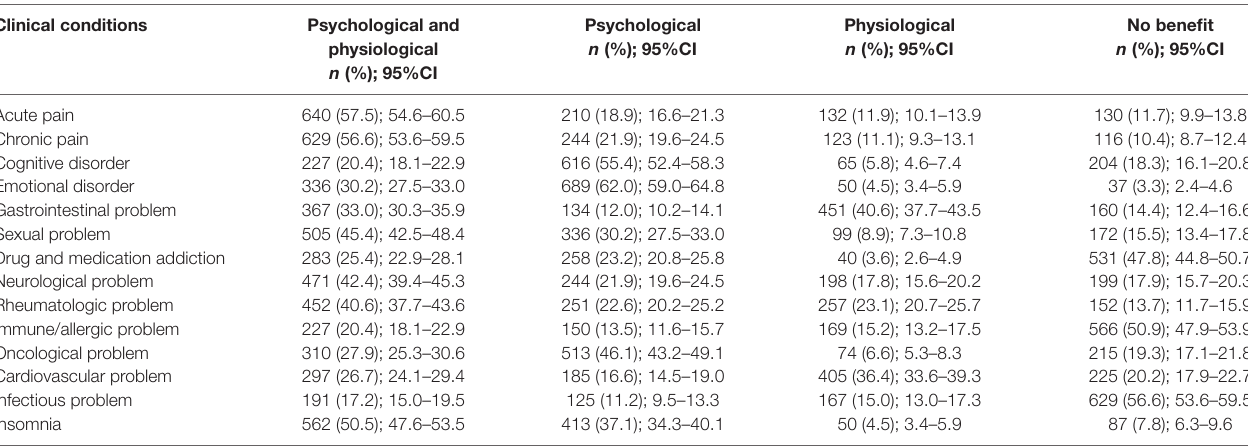
TABLE 3 | Therapeutic effect(s) of contextual factors ( n =